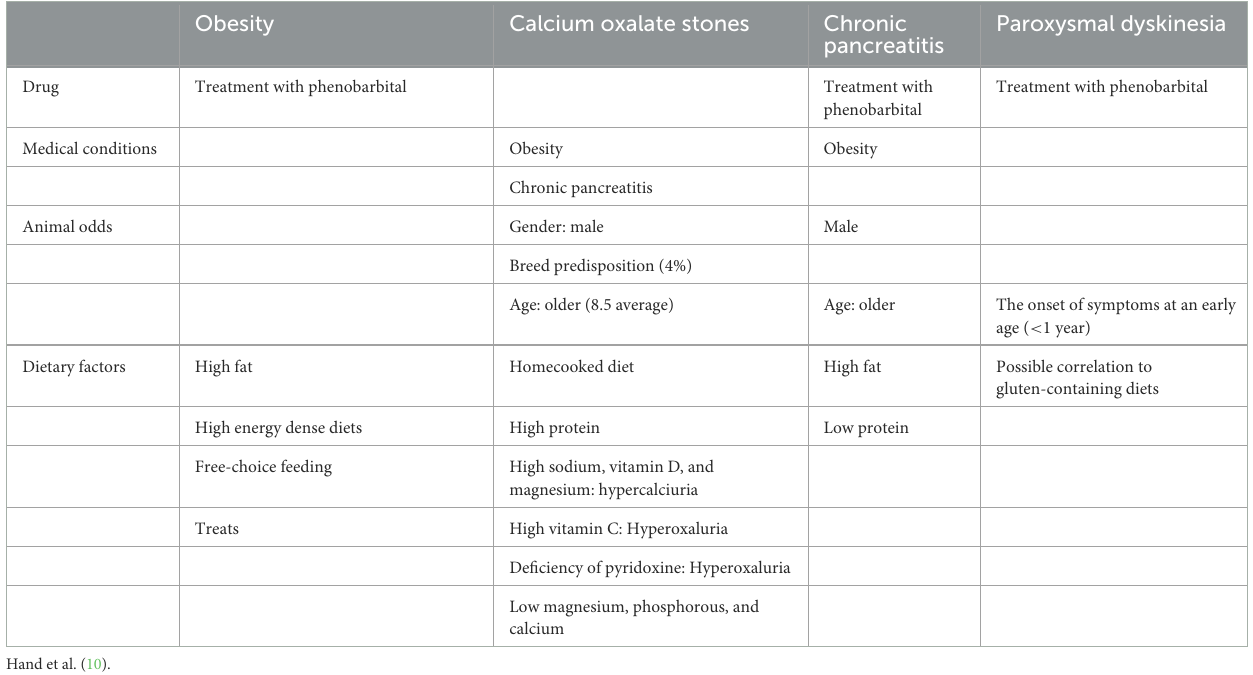
TABLE 2 List of risk factors for each associated disease that were taken into account for this patient’s nutritional recommendation.